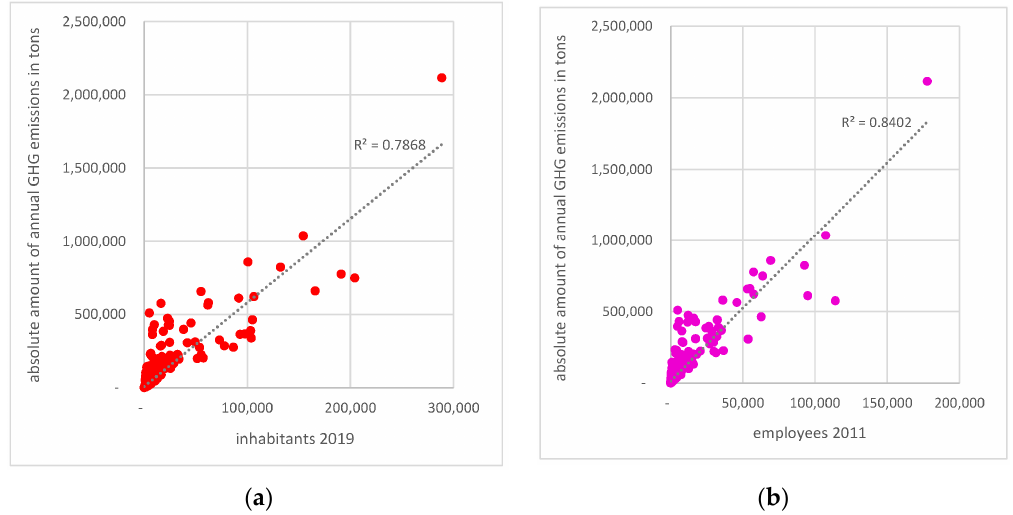
Figure 3. The correlation between the absolute amount of annual GHG emissions and the number of ( a ) inhabitants; ( b ) employees; (without Linz that figures extraordinarily high GHG emissions from industry).